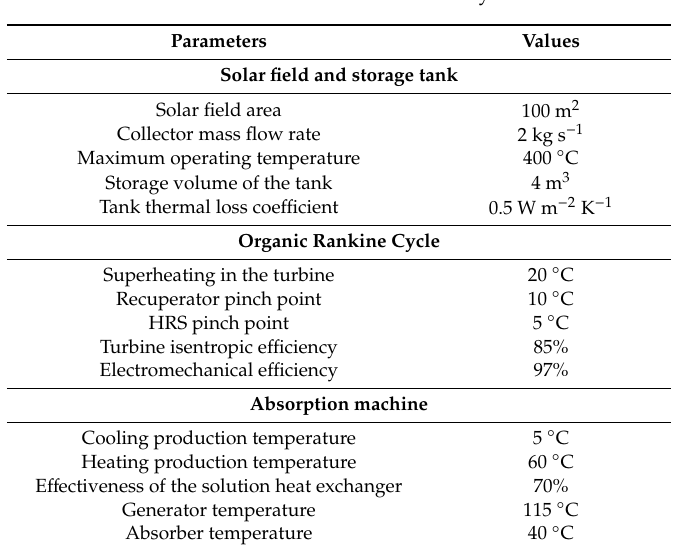
Table 1. Main data of the studied